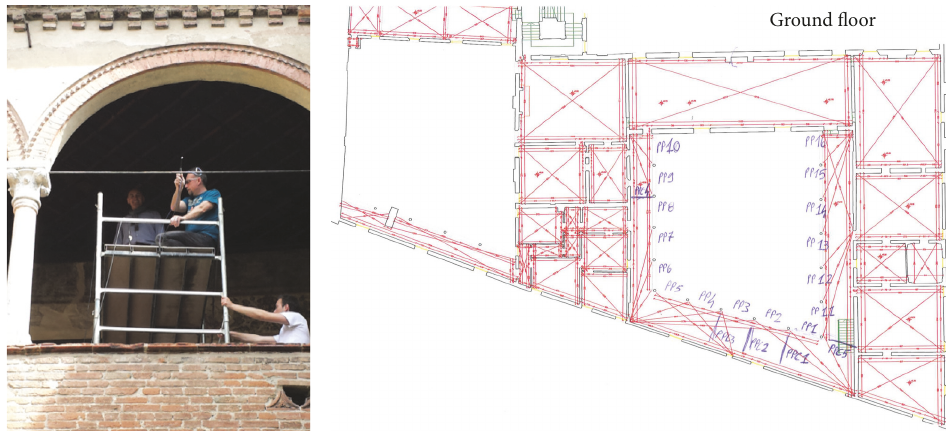
Figure 4: Our team during hammer excitation of a tie-rod; map of ground